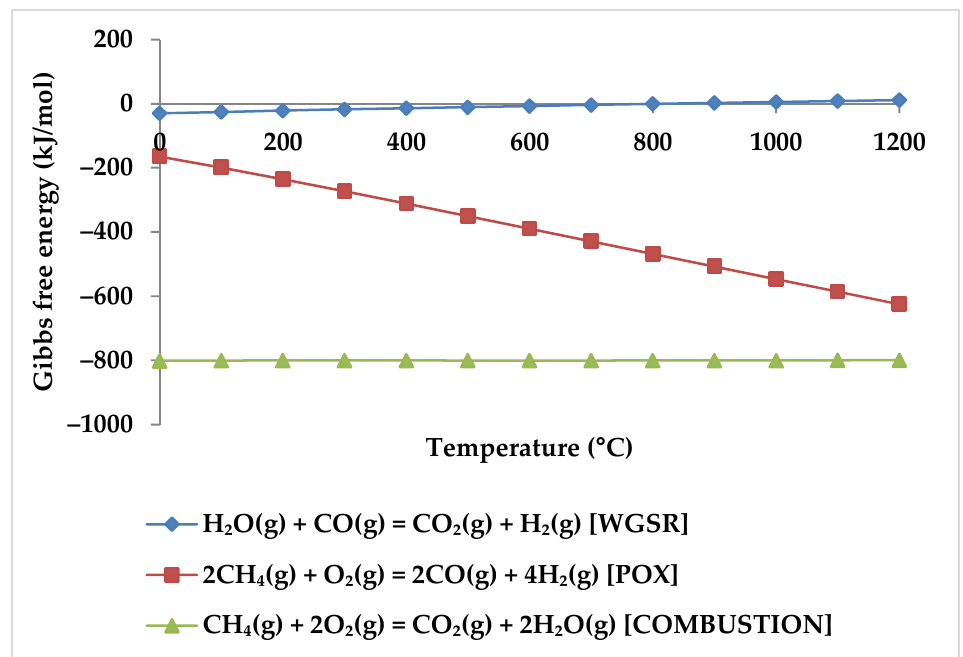
temperature ranges, appears to be the cause. WGSR is also likely to occur alongside the POX reaction to produce H 2 but with a lower probability (Figure 6).